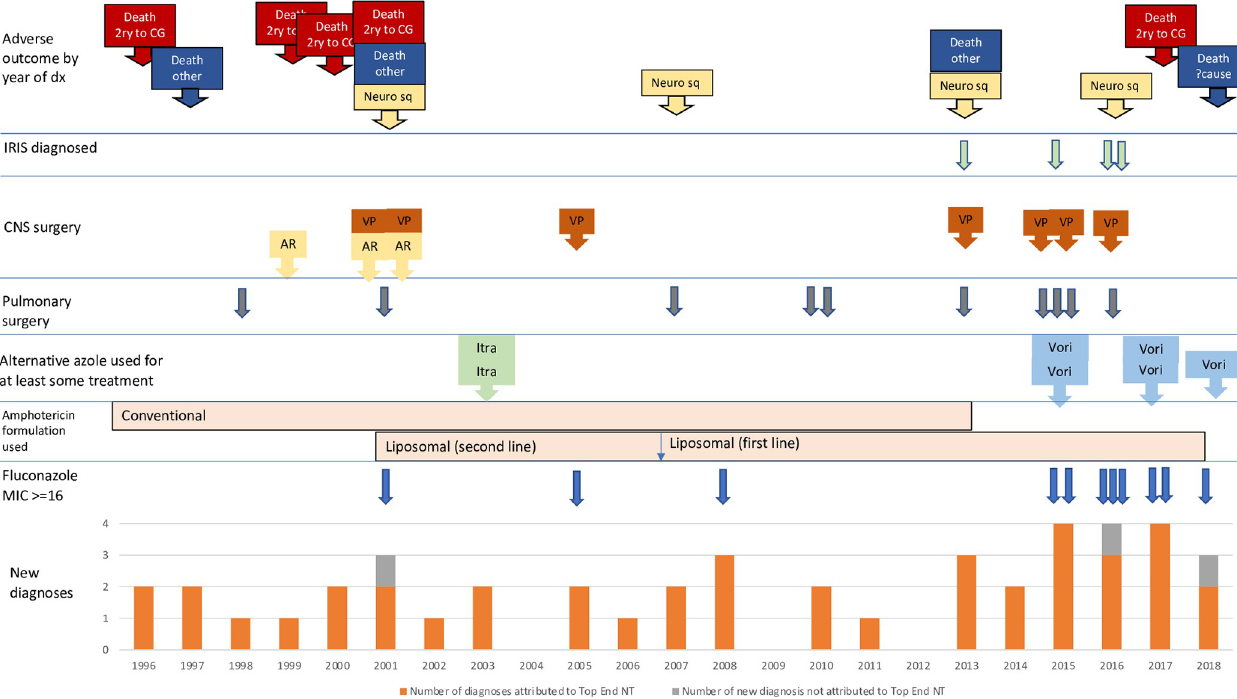
treatment. Seven patients were changed from fluconazole to alternative agents (itraconazole: two, both in 2002; voriconazole: five, all 2015 or later) for reasons of toxicity, treatment failure or high fluconazole MIC (S3 Table and Fig 3). One patient was commenced on voriconazole when diagnosed with infection persistence 12 months post cessation of fluconazole (flucona- zole MIC of the original isolate was 8 μ g/mL). For 22/30 patients confirmed to have completed treatment and duration was known, the